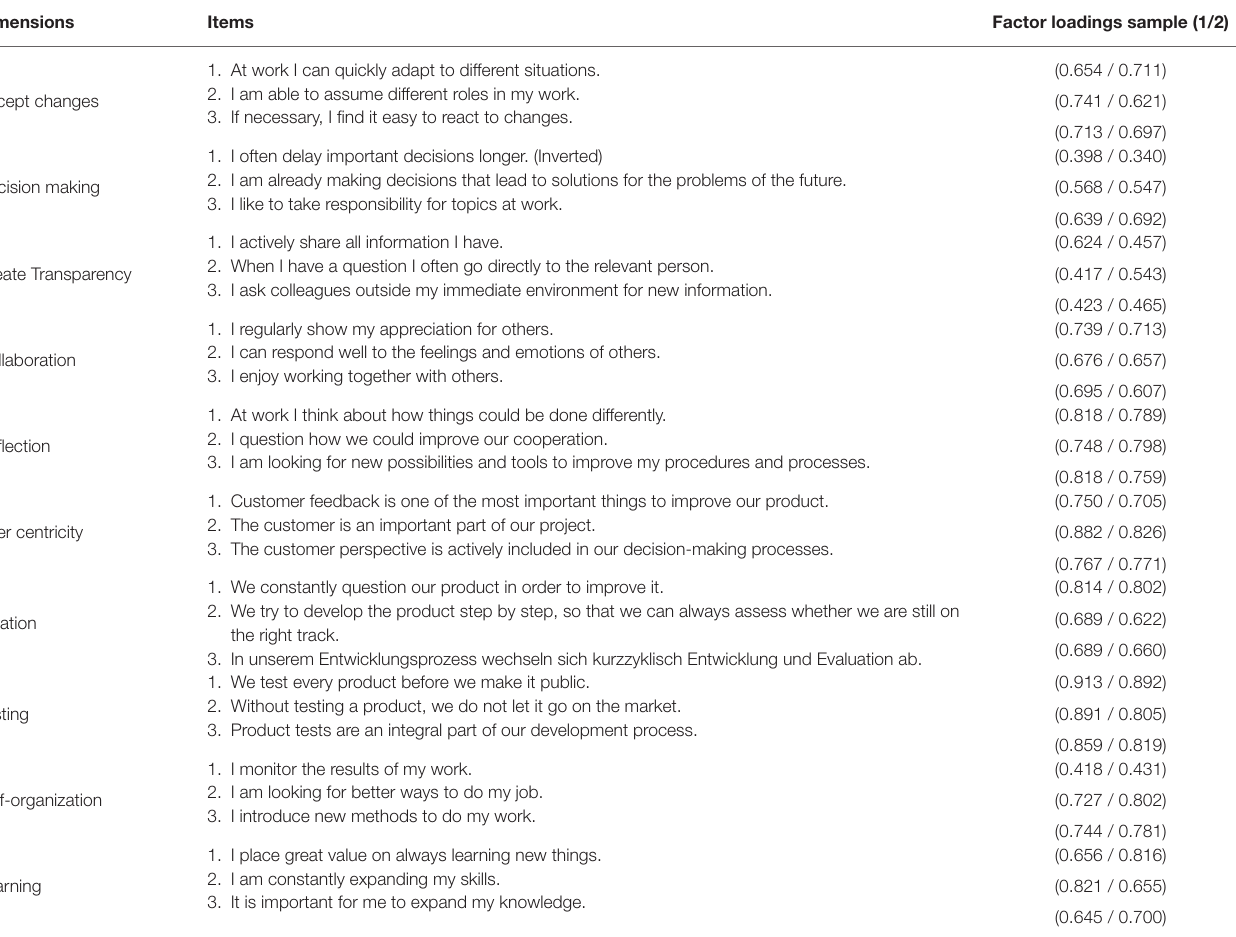
TABLE 4 | Dimensions and items of the workforce agility